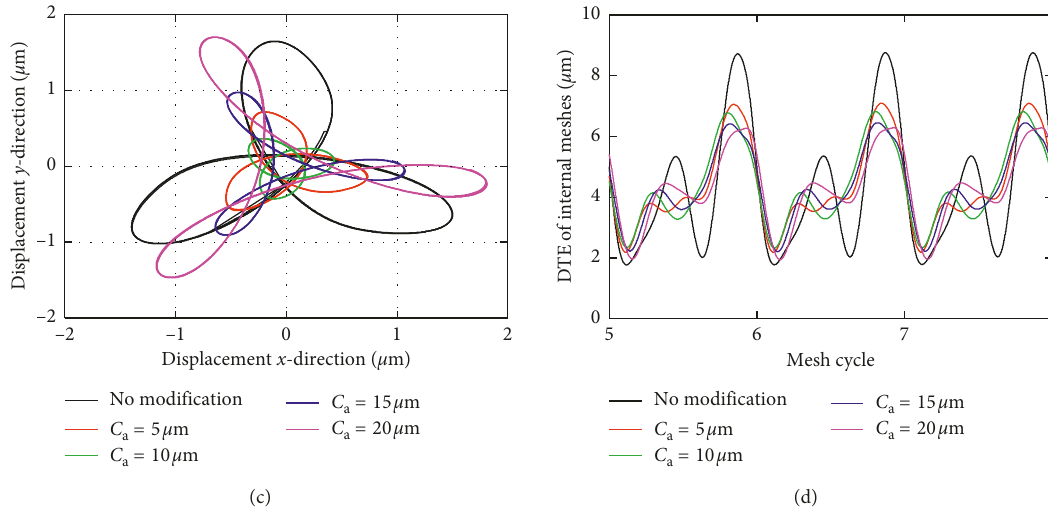
Figure 10: Dynamic responses for different amounts of TPM on external and internal meshes at sun-gear speed 7380rpm: (a) dynamic mesh force; (b) DTE of sun-planet meshes; (c) sun-gear trajectory; (d) DTE of ring-planet meshes.